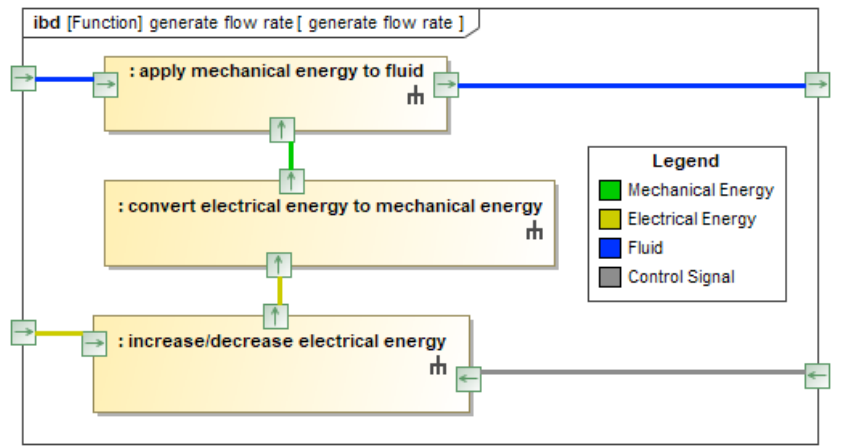
Figure 3. Functional architecture of the main function generate flow rate of the electric coolant pump.